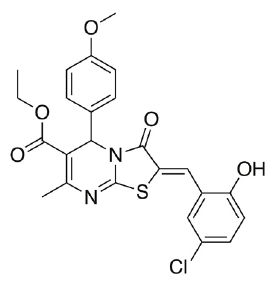
Figure 3. Compound SJ000154494 (EC in this